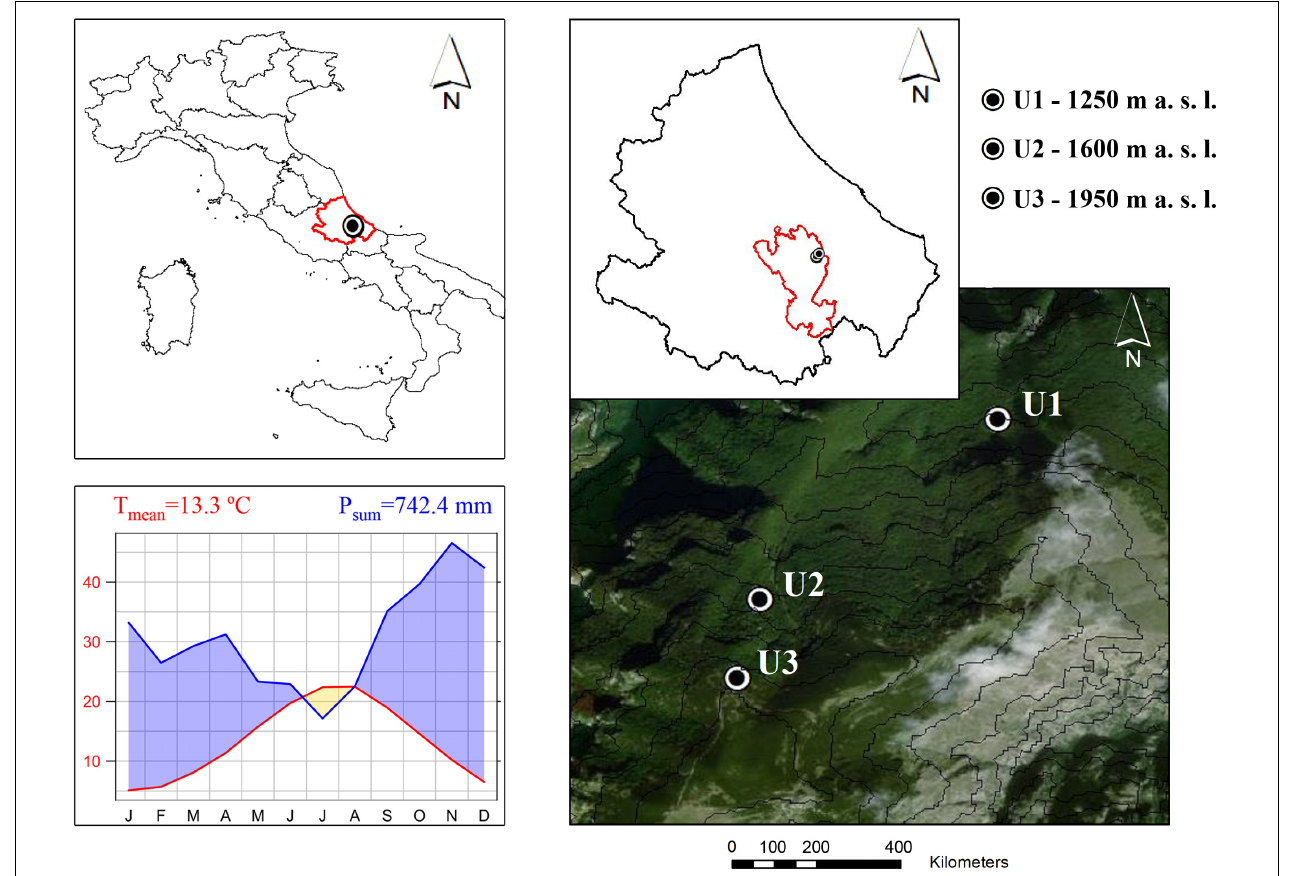
FIGURE 1 | Location of the study sites and climate diagram of the study area. T mean —mean annual temperature, P sum —mean annual precipitation (CRU TS4.04 Dataset, Harris et al., 2014).